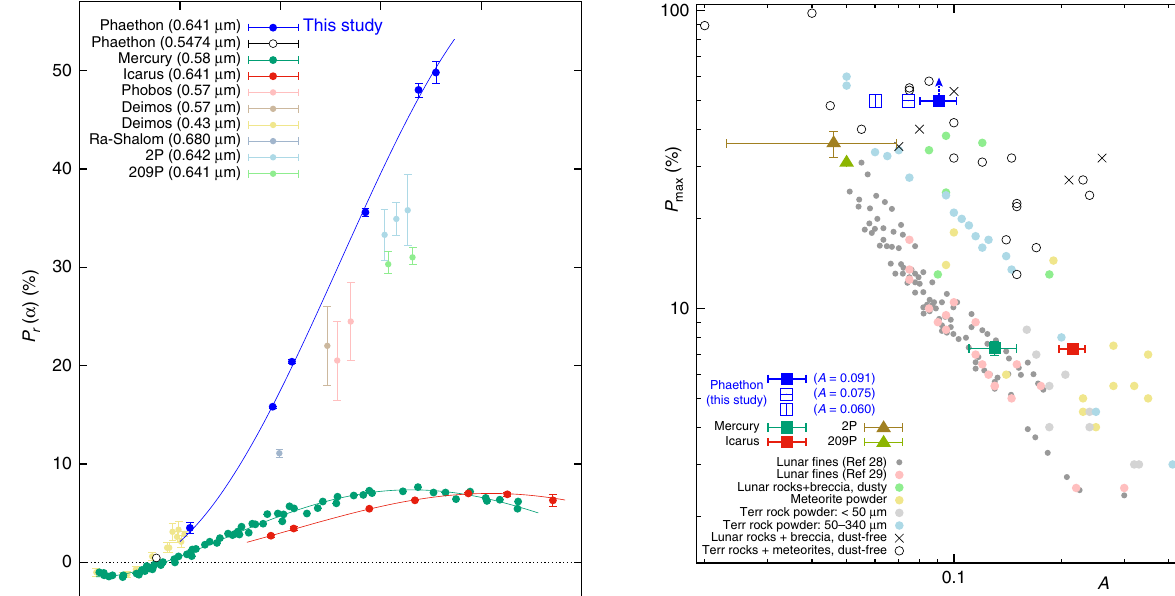
Fig. 2 Relationship between A (the geometric albedo measured at α = 5°) and P max for Phaethon and other objects. In this fi gure, Phaethon is represented by three kinds of blue squares: The blue- fi lled square that uses Fig. 1 Dependence of the linear polarization degree P r of Phaethon (the the current albedo estimate in ref. 27 and its error bars, the blue open blue- fi lled circles) on solar phase angle ( α ) in the R C -band centered at the square with a horizontal bar that uses the albedo estimate brought by a wavelength of 0.641 μ m. For comparison, P r values of some other solar recent radar observation 36 , and the blue open square with a vertical bar that uses an albedo estimate calculated from the absolute magnitude value of H = 14.6 presented in ref. 38 . See Discussion for the latter two estimates. Note that the vertical value for Phaethon is not actually P max , but the observed largest value of P r during our observation (Fig. 1). Therefore, we have added an upper arrow to the blue- fi lled square for showing that Phaethon ’ s P max is larger than this value. Data for the terrestrial, meteoritic, and lunar samples are all taken from the tables described on ref. 29 except for those designated as “ Lunar fi nes Ref 28 ” adopted from ref. 28 ’ s Fig. 2. The lunar fi ne data adopted from ref. 29 ’ s Table 1 are designated as “ Lunar fi nes Ref 29 . ” Note that in the legend we use the abbreviation “ Terr rock ” for terrestrial rock. The data for Mercury is from ref. 33 , and that for (1566) Icarus is from ref. 31 . The albedo of 2P is adopted from ref. 70 , and that of 209P is from ref. 68 . Note also that wavelengths for each of the measurements differ from sample to sample. Error bars seen on symbols of Icarus, Mercury, 209P, and 2P are adopted from the literature. The data fi gure because their P values for Phaethon and Icarus plotted in this fi gure are available r values plotted in Fig. 1 can be regarded as being close to P max . We excluded Phobos, Deimos, and (2100) Ra-Shalom because it is not certain whether their P r values in Fig. 1 are close to P max .